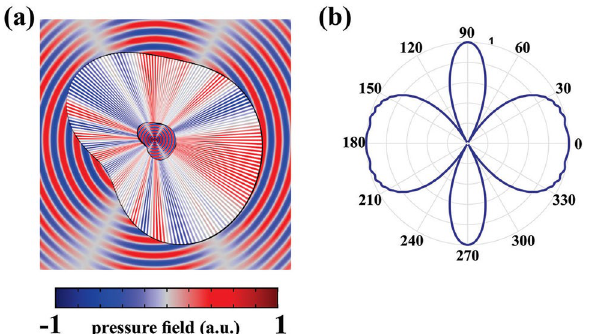
Figure 9. ( a ) The pressure field of an ASML realized with the materials extracted from proposed acoustics metamaterials. ( b ) Its corresponding far field distributions. The farfield result clearly demonstrate the retrieval of the image